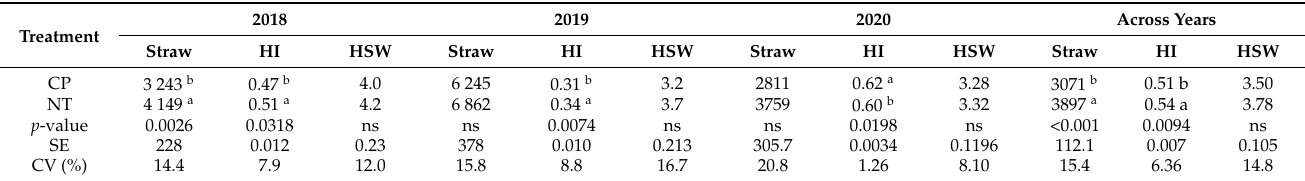
Table 3. Wheat straw yield (kg ha − 1 ), harvest index and hundred seed weight (g) in 2018, 2019, 2020 and across seasons.